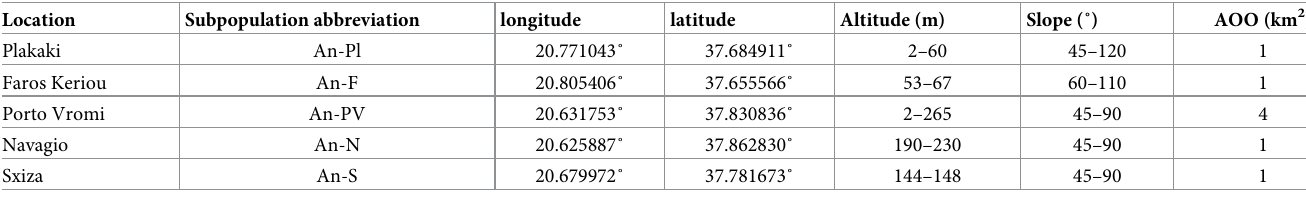
Table 1. Geographical data of Asperula naufraga subpopulations.